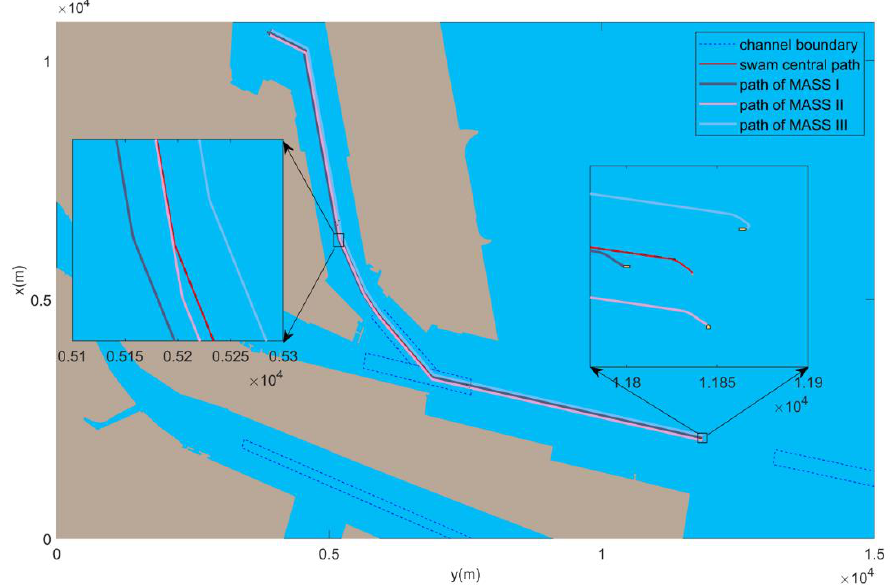
Figure 14. Path tracking result for swarm of MASSs.